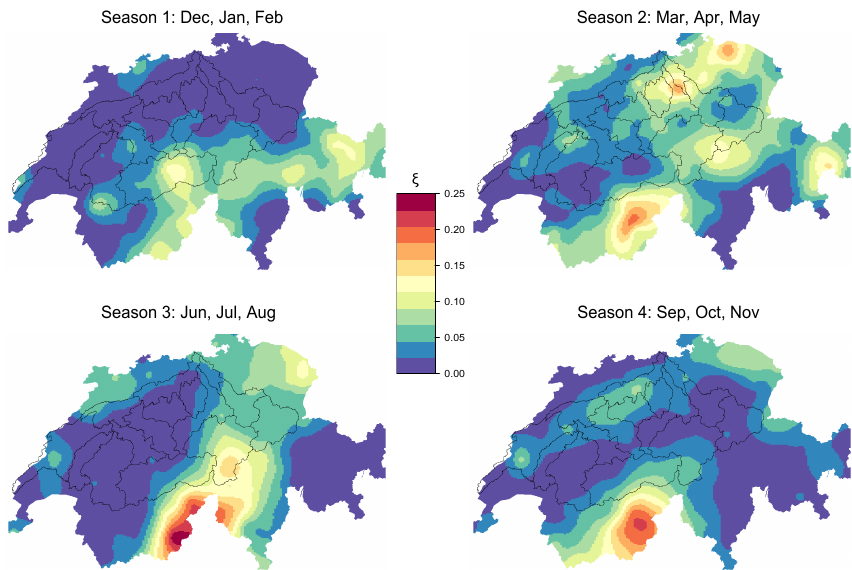
Figure 4. Regionalized ξ parameters at a daily scale, for the different seasons. Here, we present the spatial interpolation of at-site estimates for a better readability of their variability.